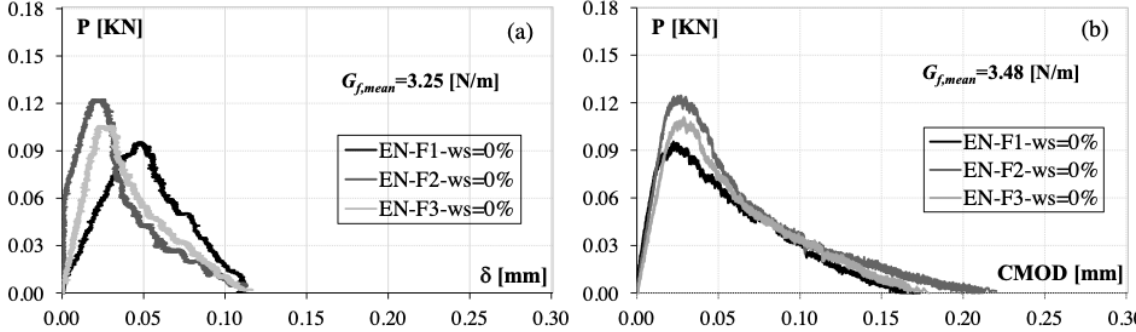
Figure 3. Evaluation of the average fracture energy for specimens with nominal density of 350 kg/m 3 and moisture content ws of (0 2) % by considering: a) the load P -deflection δ curve; b) the load P-CMOD curve, according to ± [27].